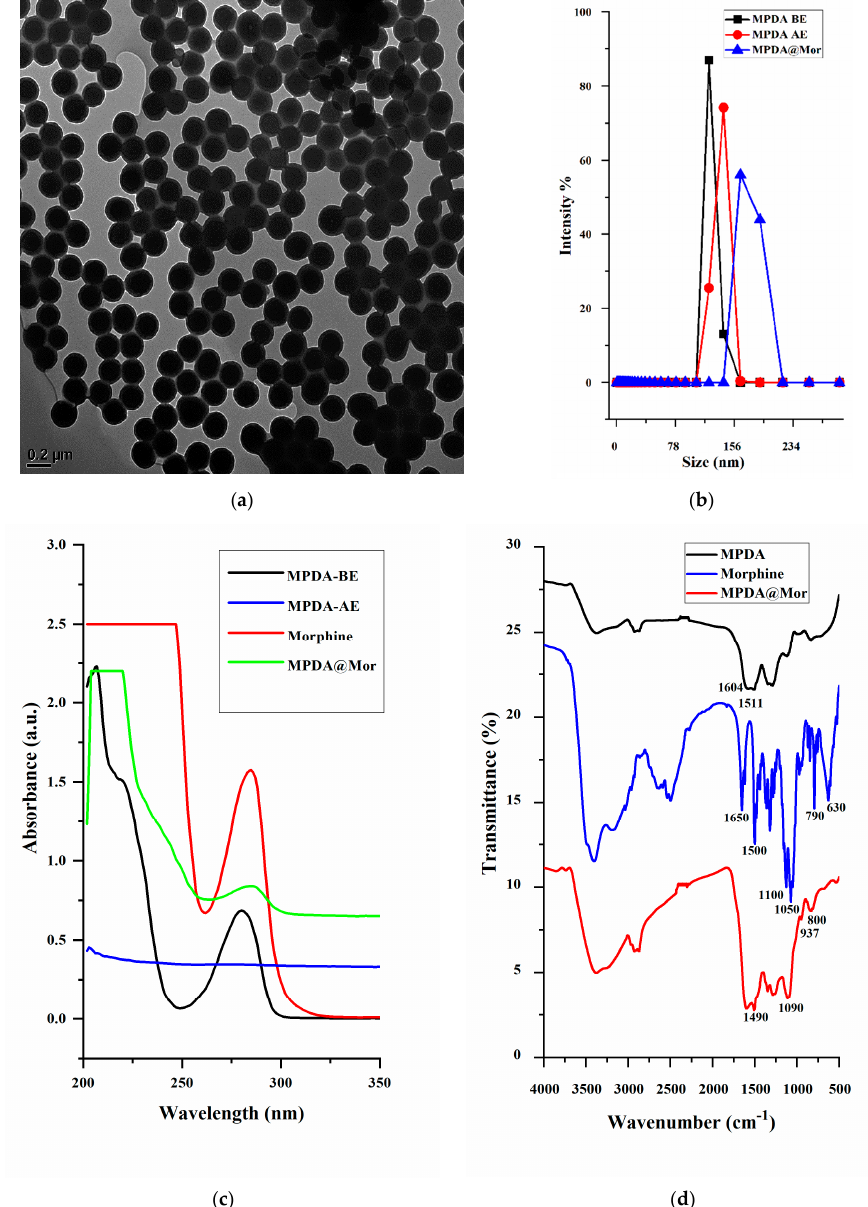
Figure 2. ( a ) TEM image of template extracted MPDA ( b ) hydrodynamic diameter distribution of BE and AE MPDA and MPDA loaded morphine (MPDA@Mor). ( c ) UV-vis and ( d ) FT-IR spectra of morphine, MPDA and MPDA@Mor.